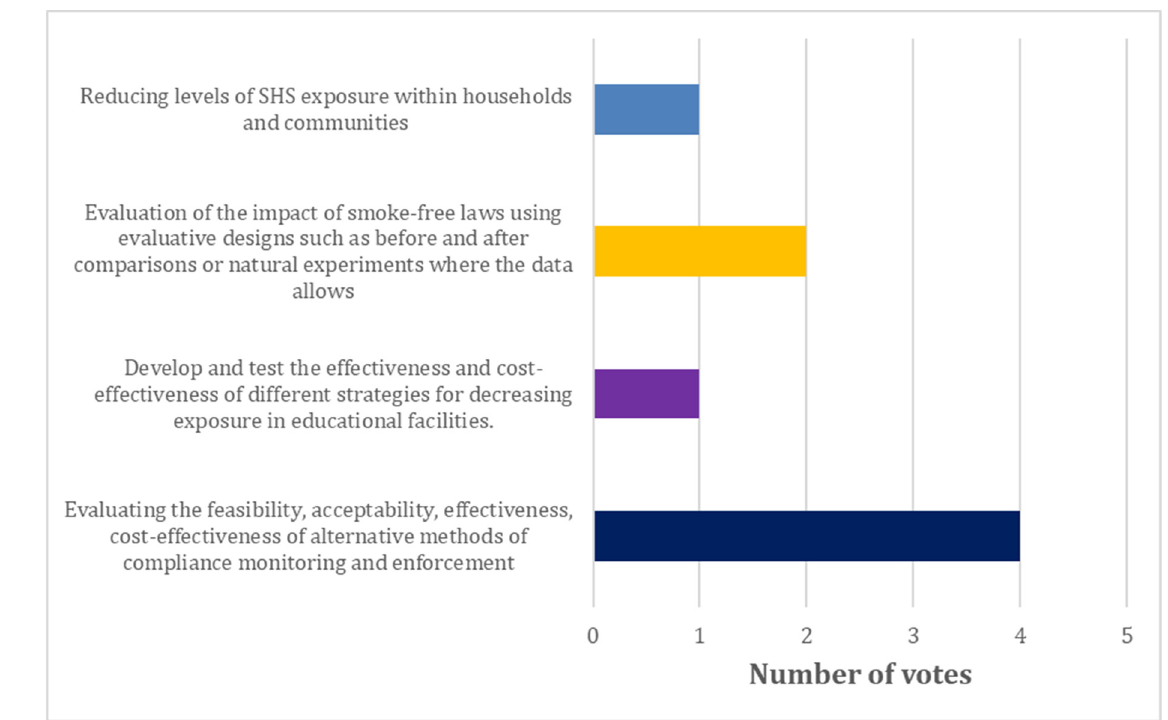
Figure 2. Stakeholder poll results.